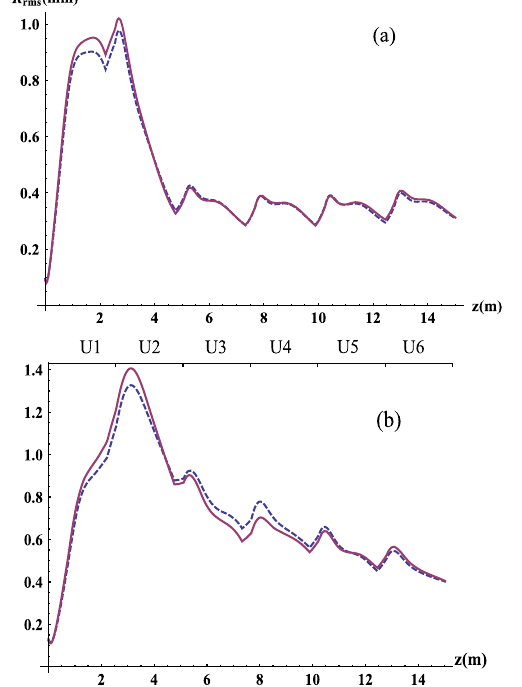
FIG. 7. Radiation spot size (rms) along the undulator calculated with GENESIS for the matching condition (blue dashed line) and an alternative transport (red continuous line). The cases (a) and (b) are relevant to an initial e-beam rms section of 0.06 and 0 . 1 mm 2 respectively; a 450 A peak current and 160 pC charge, the setting of the quadrupole currents are reported in Table V.